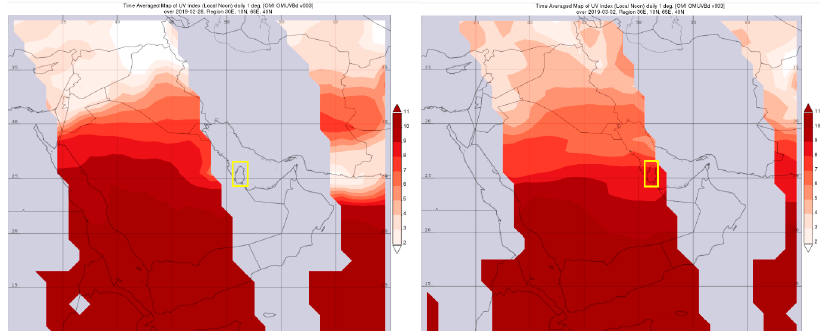
Figure 12. OMI Aura UVI plots for the Arabian Peninsula on (left) 28 February, 2019, and on 2 (right) March, 2019 generated using NASA’s GIOVANNI platform. All data that are greyed out are from where the satellite did not pass over and thus did not have UVI information. Qatar is highlighted in a yellow box.